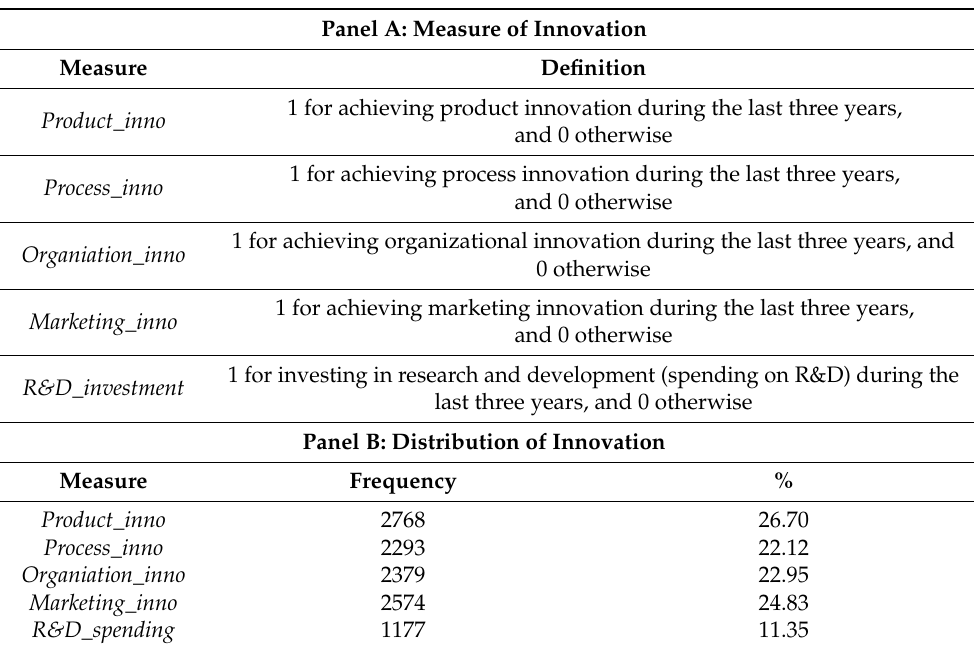
Table 2. Dependent variable of main regression. Panel A: Measure of